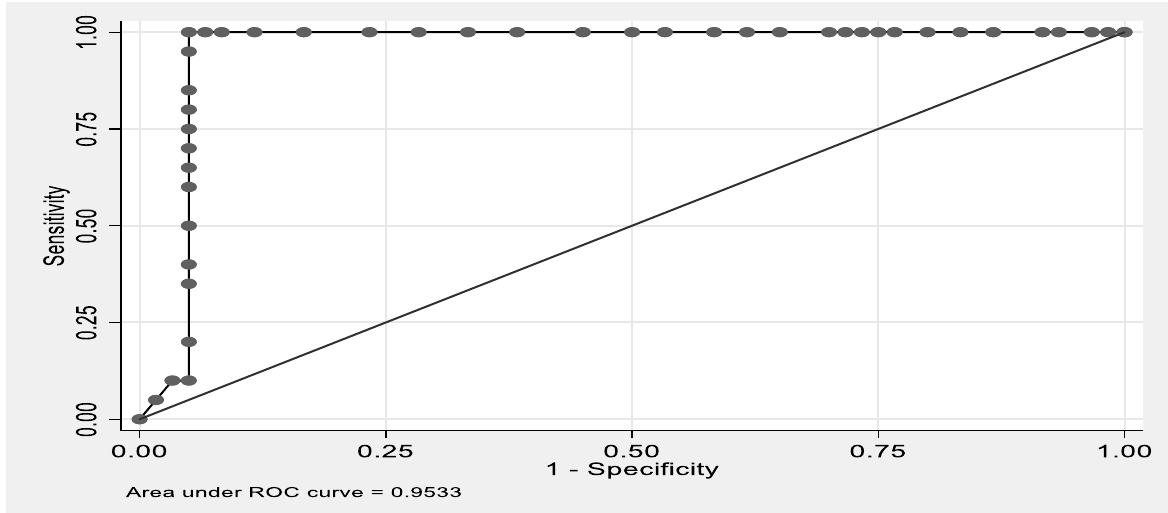
Fig. 6 ROC curve for the discriminatory power of FABP in the differentiation between normoalbuminuria vs normal